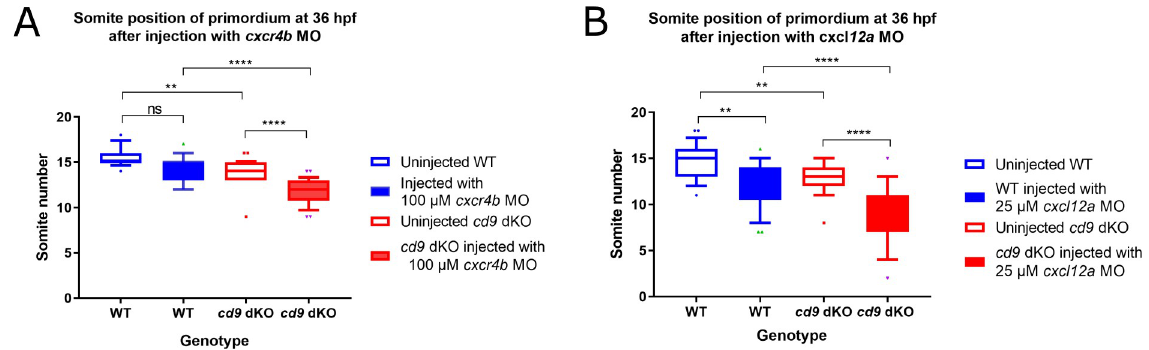
Fig 7. cxcr4b and cxcl12a MOs further delay primordium migration at 36 hpf in cd9 dKO embryos. A-B: Distance migrated by the primordium (labelled by claudin b ISH) were recorded for (a) injection of 100 μ M cxcr4b MO, and (b) 25 μ M cxcl12a MO. Significance was assessed using one-way ANOVA, � = p < 0.05, �� = p < 0.01, ��� = p < 0.001 ���� = p < 0.0001. N = minimum 15. Box extends from the 25th to 75th percentile and whiskers from 10th to 90 th